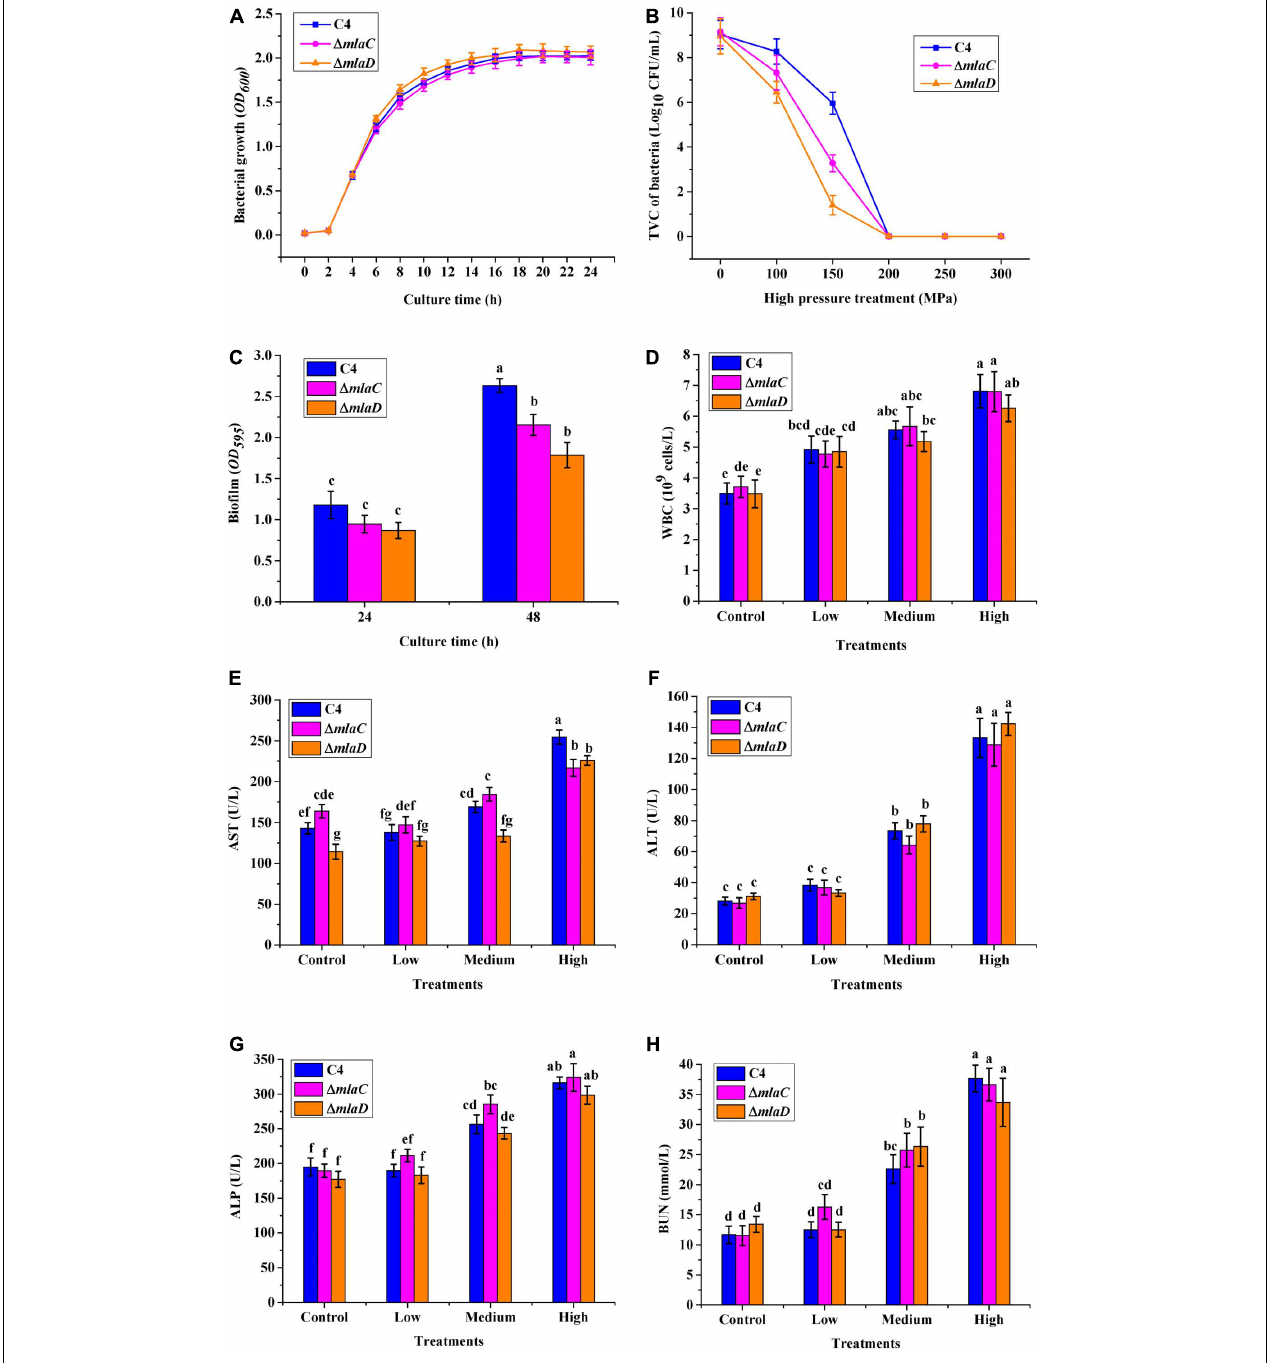
FIGURE 9 | High-pressure tolerance and in vivo virulence test of KO strains. (A) Growth curve. (B) High-pressure tolerance of WT and KO strains under high-pressure treatment. (C) Biofilms formed by different strains after culture for 24 and 48 h. (D) WBC. (E) AST. (F) ALT. (G) ALP. (H) BUN.